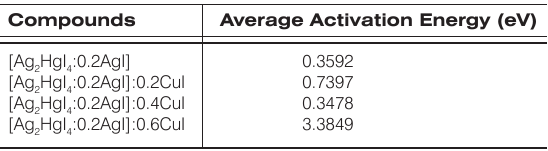
Table 2. Average activation energies extracted from the curve slopes by a standard Arrhenius analysis.